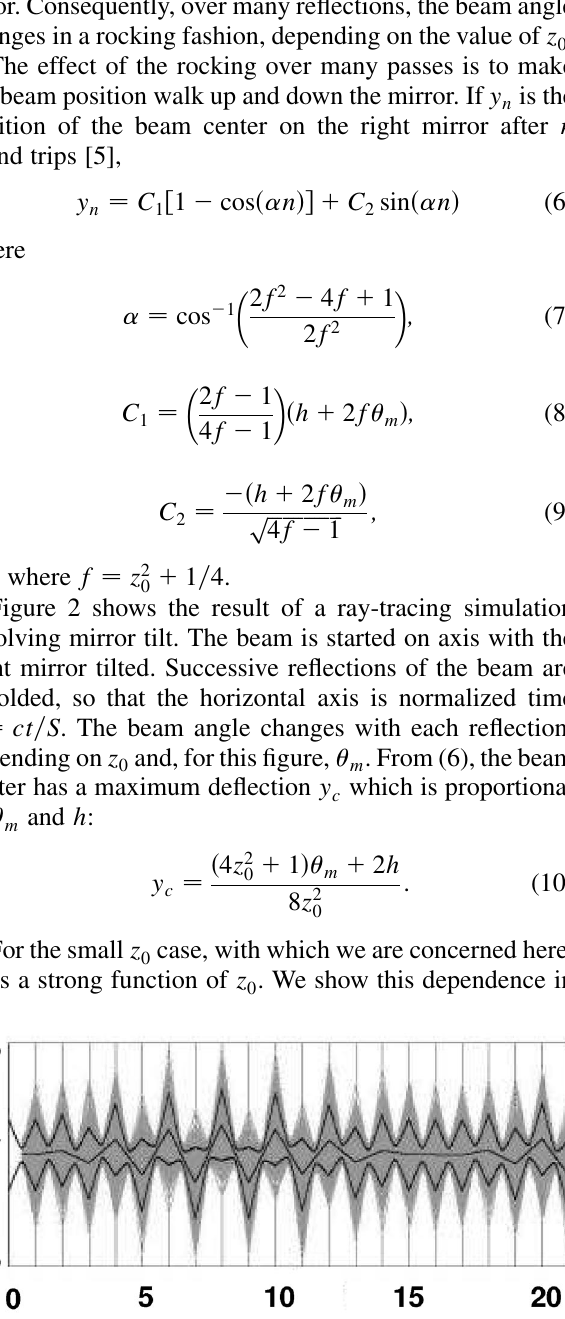
FIG. 2. Evolution of an optical beam in a resonator with z (cid:2) 0 : 05 , and h (cid:2) 0 . The y axis is the normalized trans- 0 : 1 , (cid:3) m verse distance, and (cid:8) is the normalized time. Each vertical line corresponds to a mirror, with successive reflections unfolded to see the overall behavior. The shaded area shows the trajectories of 1000 random rays; the center line is the center of the optical beam; and the top and bottom lines, calculated from beam theory, correspond to the radius w for the Gaussian mode. The effect of mirror tilt is to make the beam rock back and forth on the resonator mirrors.